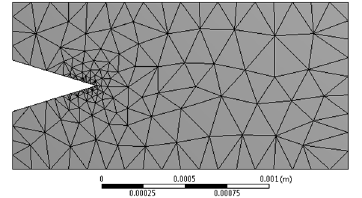
Figure 13. Pre-meshed crack for the second case.